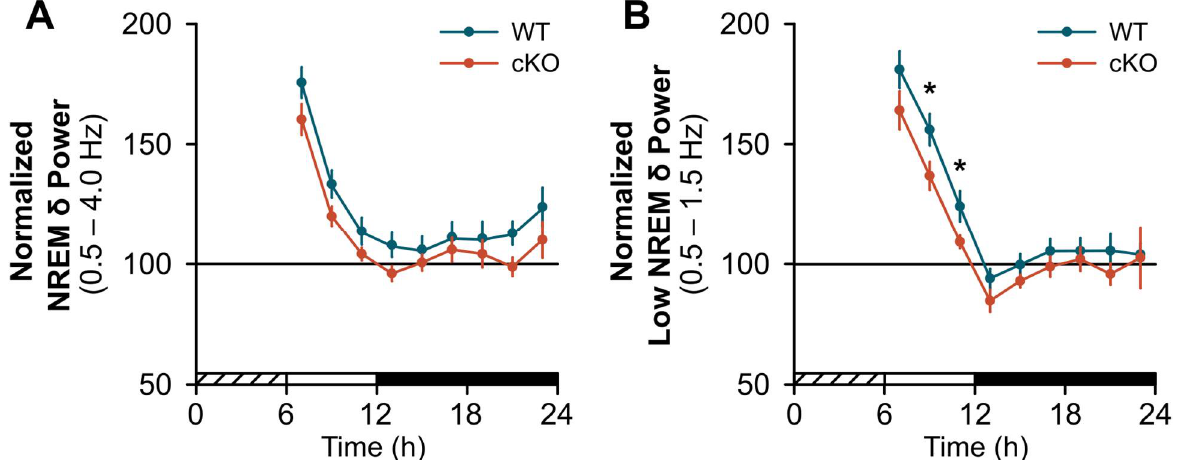
Figure 3. Conditional deletion of astroglial β2-ARs blunts the compensatory response to sleep deprivation (SDep): NREM slow-wave activity (SWA). Normalized NREM SWA for ( A ) delta (δ) bands (0.5–4.0 Hz) and ( B ) low delta bands (0.5–1.5 Hz) shown in 2 h bins post-SDep. Cross-hatched bars on the x -axis denote the 6 h SDep period. Open and closed bars on the x -axis denote the recovery phase light and dark periods, respectively. Values are means ± SE from n = 13 WT and n = 13 cKO mice. * p < 0.05 (repeated measures ANOVA).